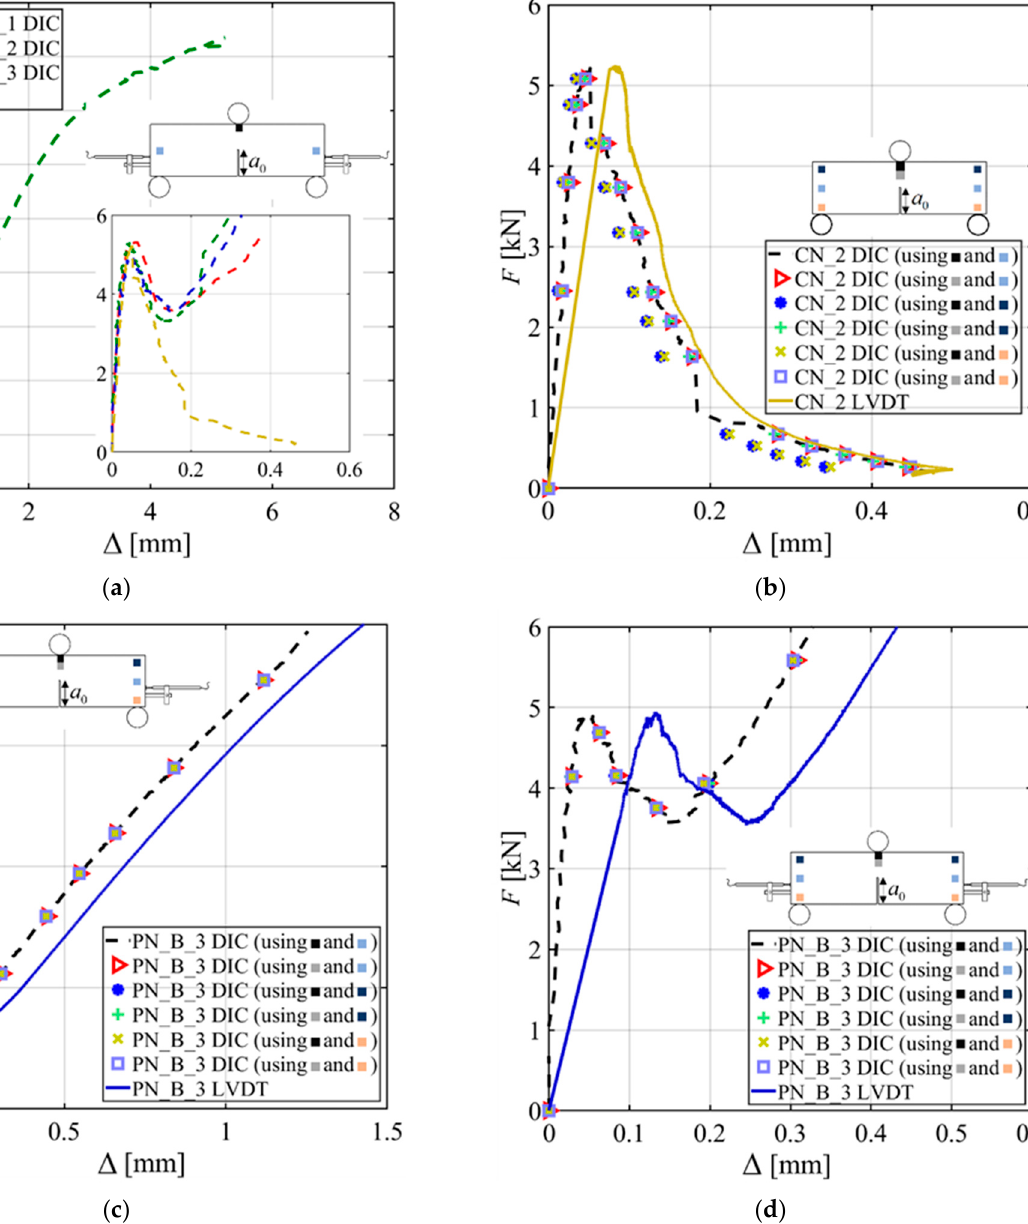
Figure 9. Load responses from DIC analysis: ( a ) F - Δ for all the specimens equipped with DIC; ( b ) Comparison of F - Δ responses from DIC analysis and LVDTs for CN_2; ( c ) Comparison of F - Δ responses from DIC analysis and LVDTs for PN_B_3; ( d ) Call out for the first portion of Figure 9c.